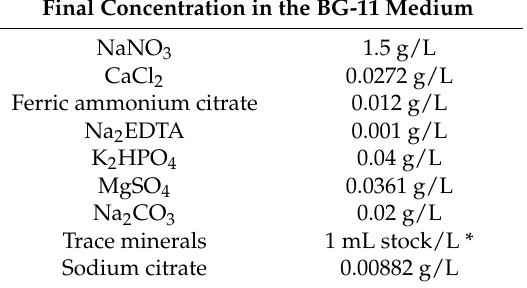
Note: * Trace mineral stock solution consists of 1.43 g H 3 BO 3 , 0.905 g MnCl 2 ¨ 4H 2 O, 0.111 g ZnSO 4 ¨ 7H 2 O, 0.195 g